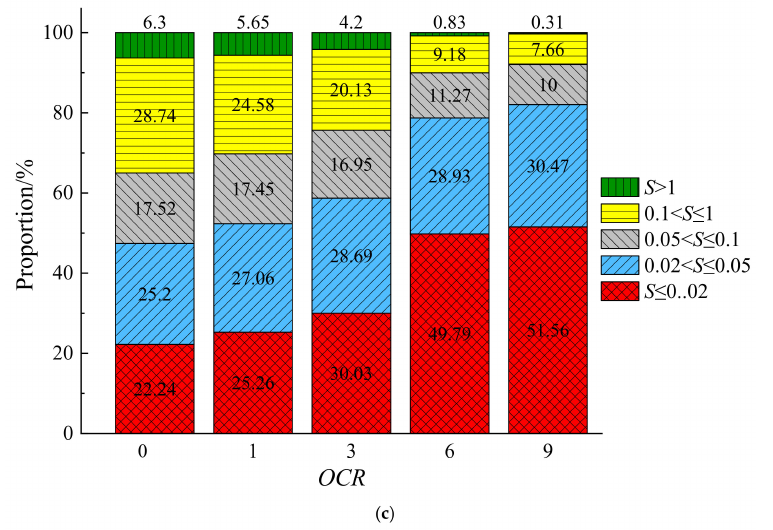
Figure 10. Changes in pore area distribution before and after loading under different test conditions: ( a ) SEM-A, ( b ) SEM-B, and ( c )